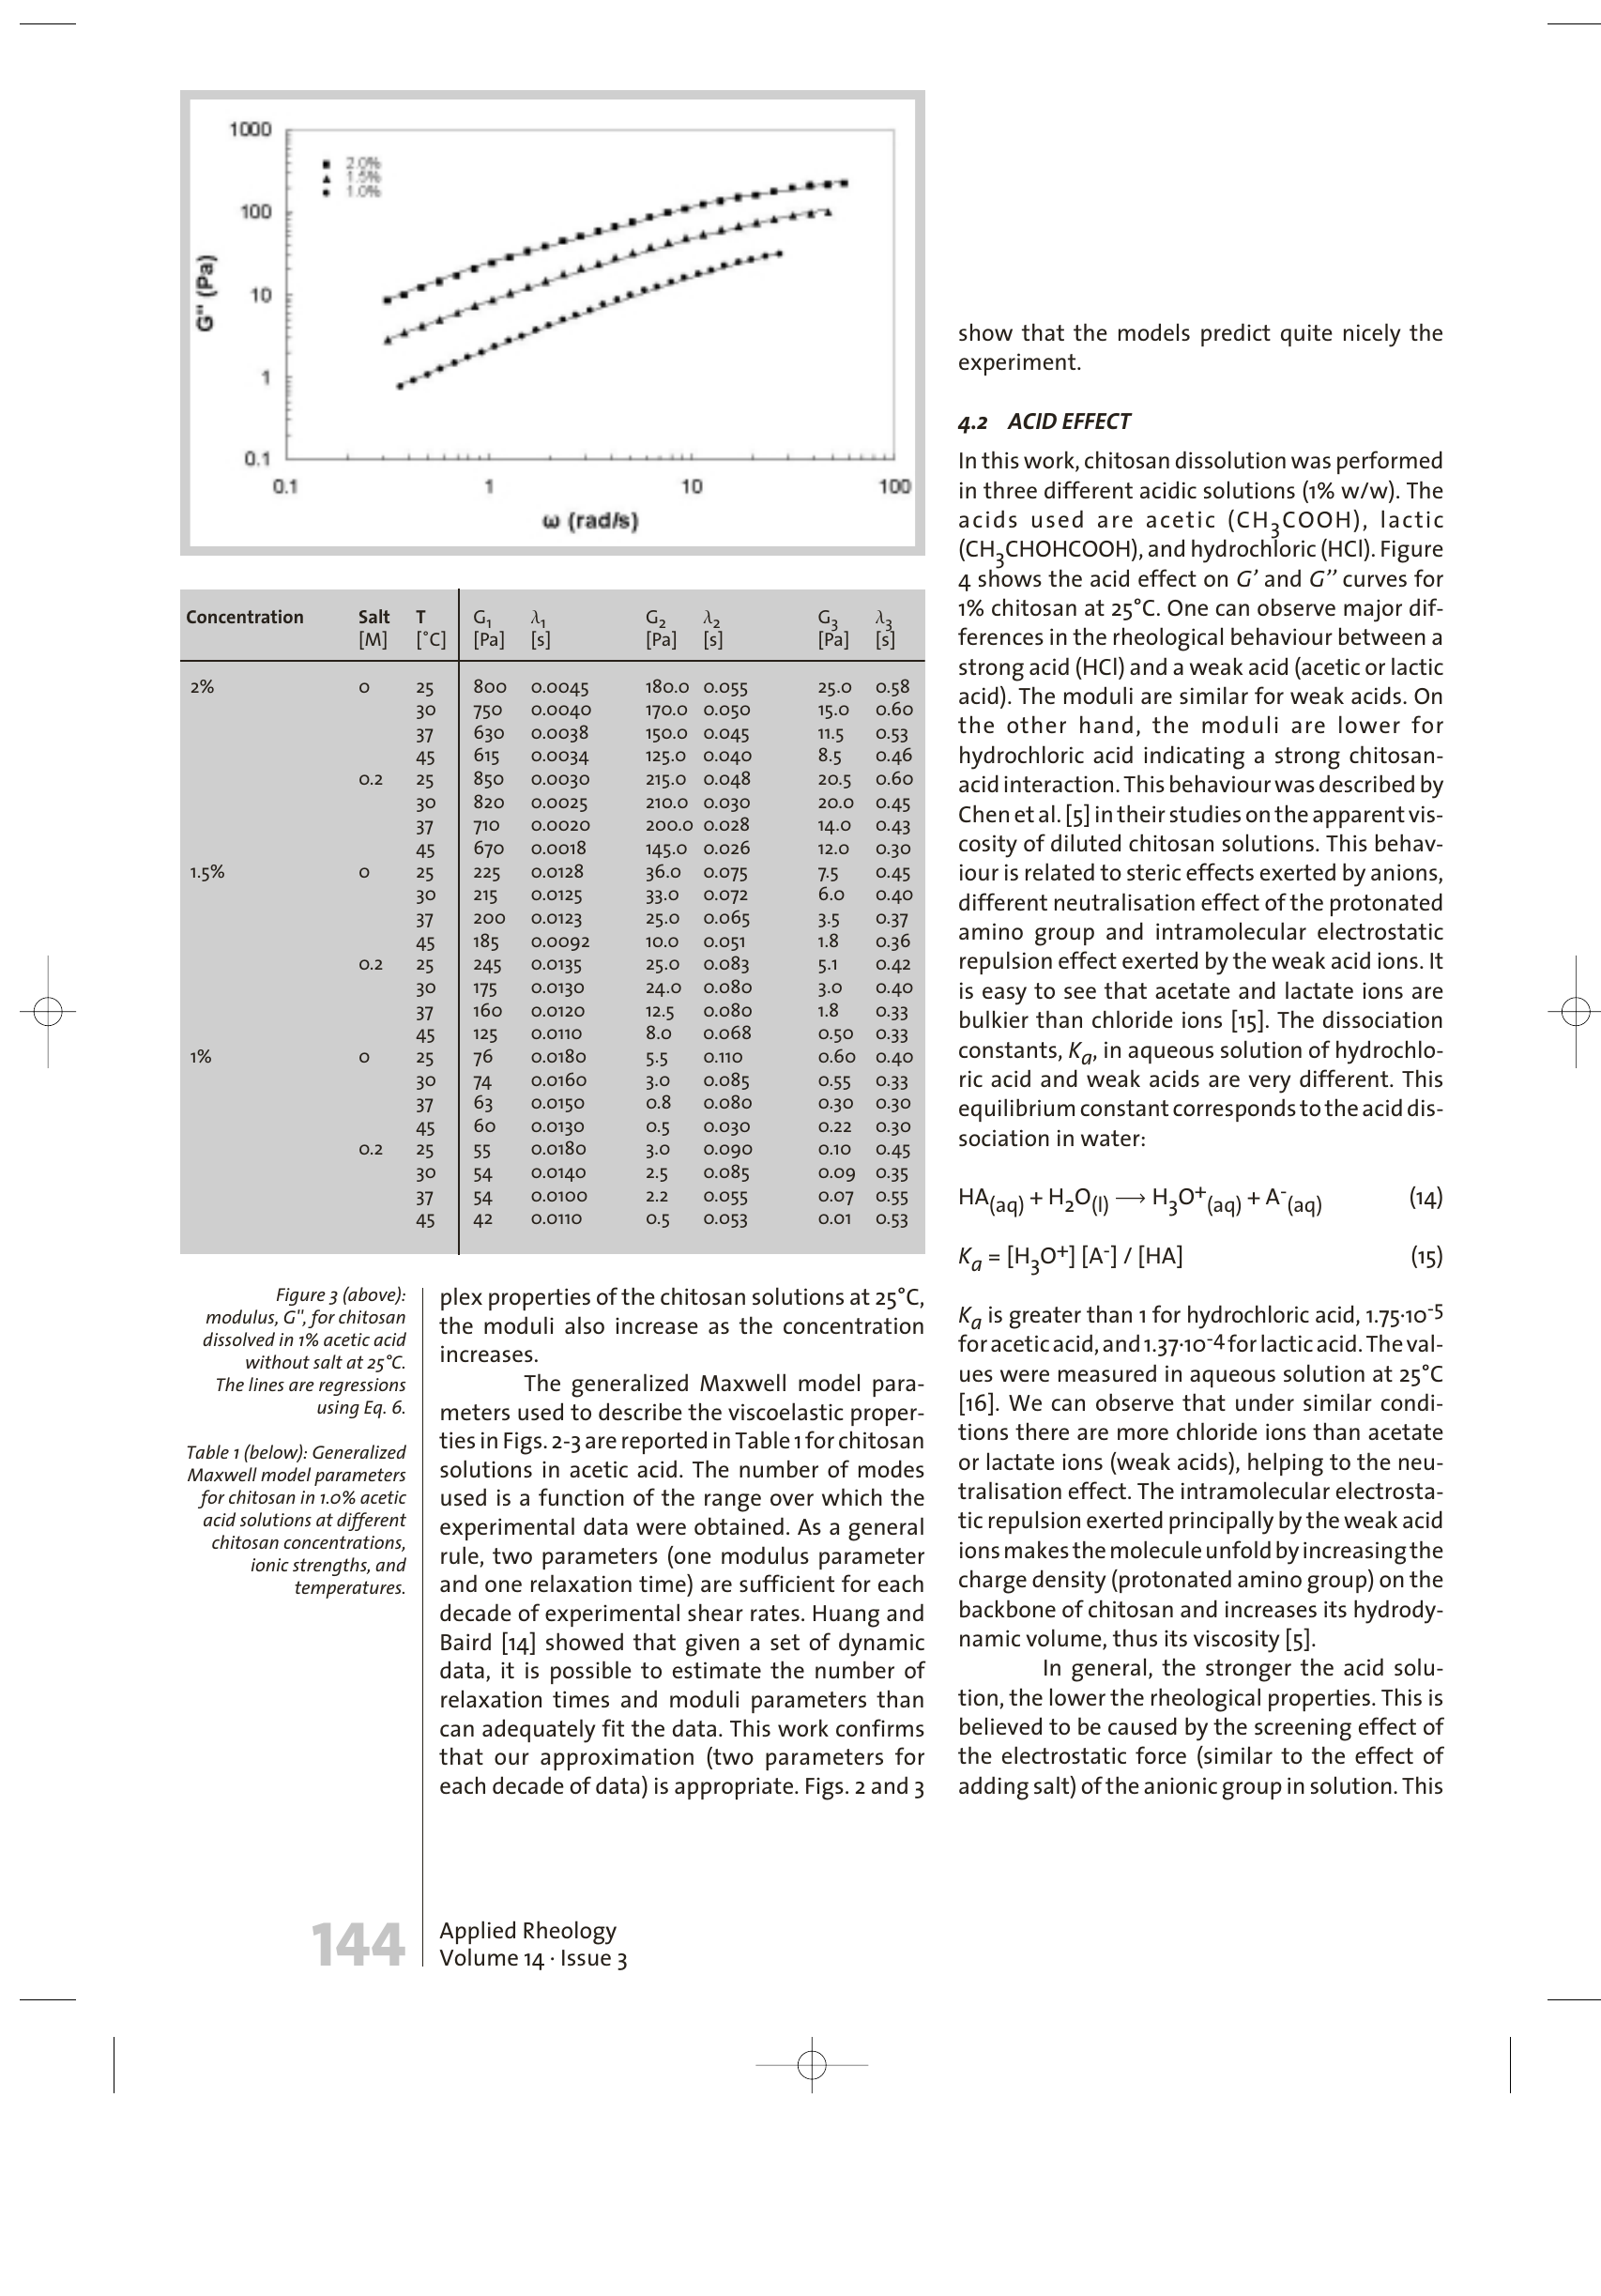
Table 1 (below): Generalized Maxwell model parameters for chitosan in 1.0% acetic acid solutions at different chitosan concentrations, ionic strengths, and